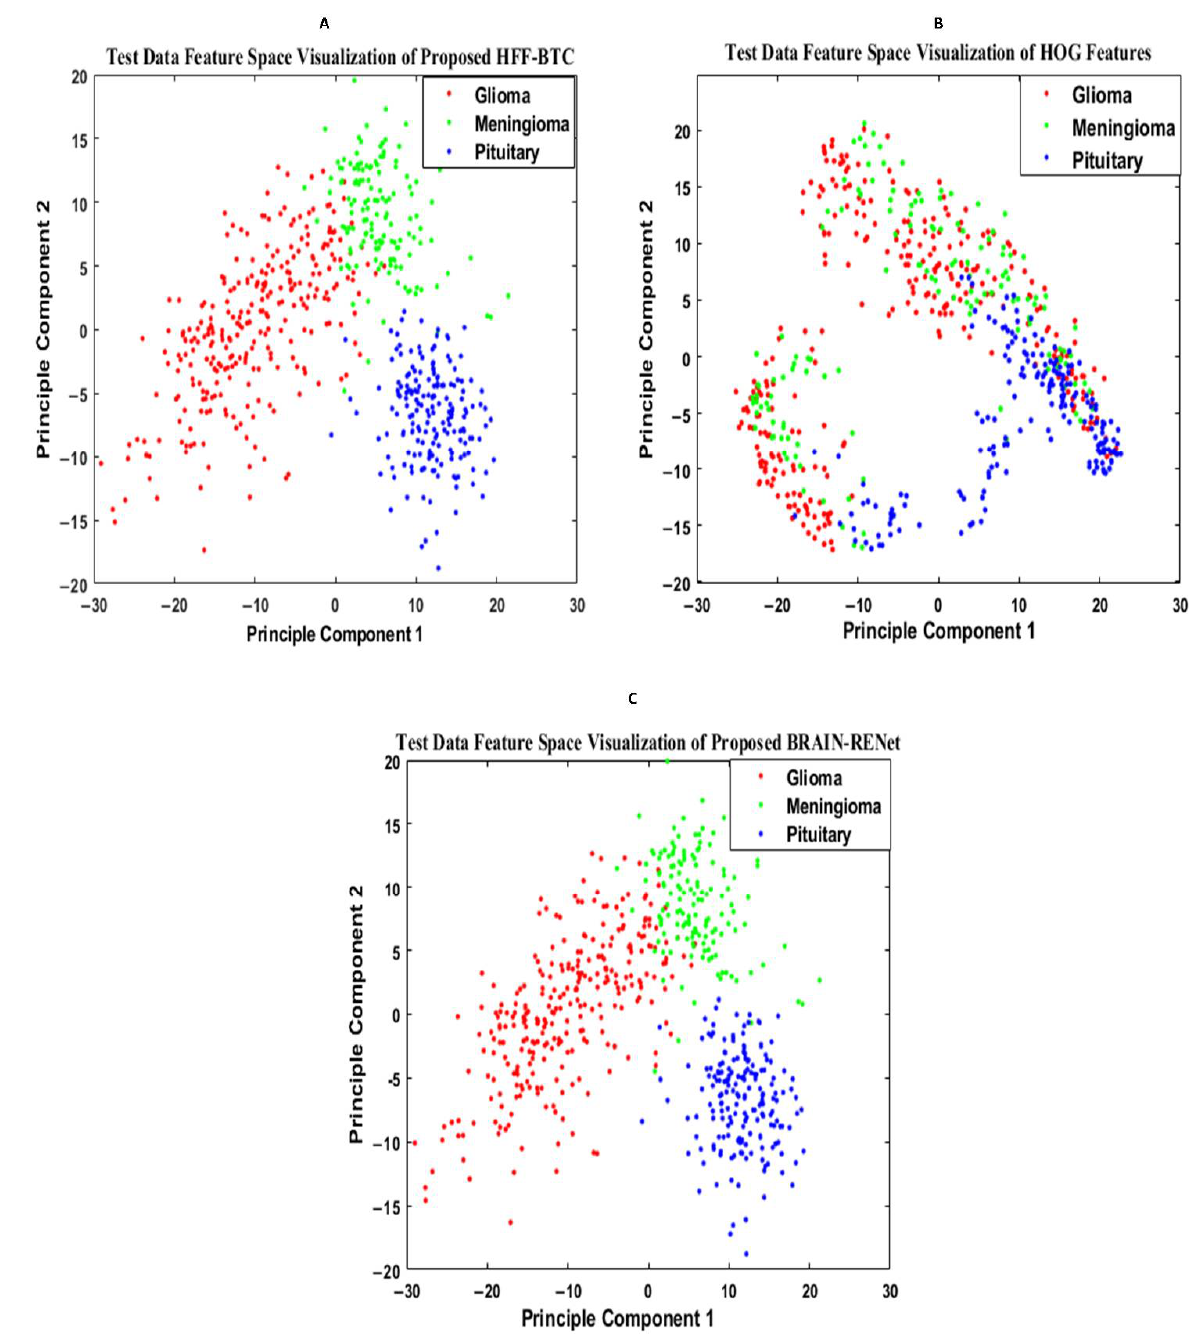
Figure 10. Feature space visualization of the proposed HFF-BTC framework ( A ), HOG descriptor ( B ), and proposed BRAIN-RENet ( C ).